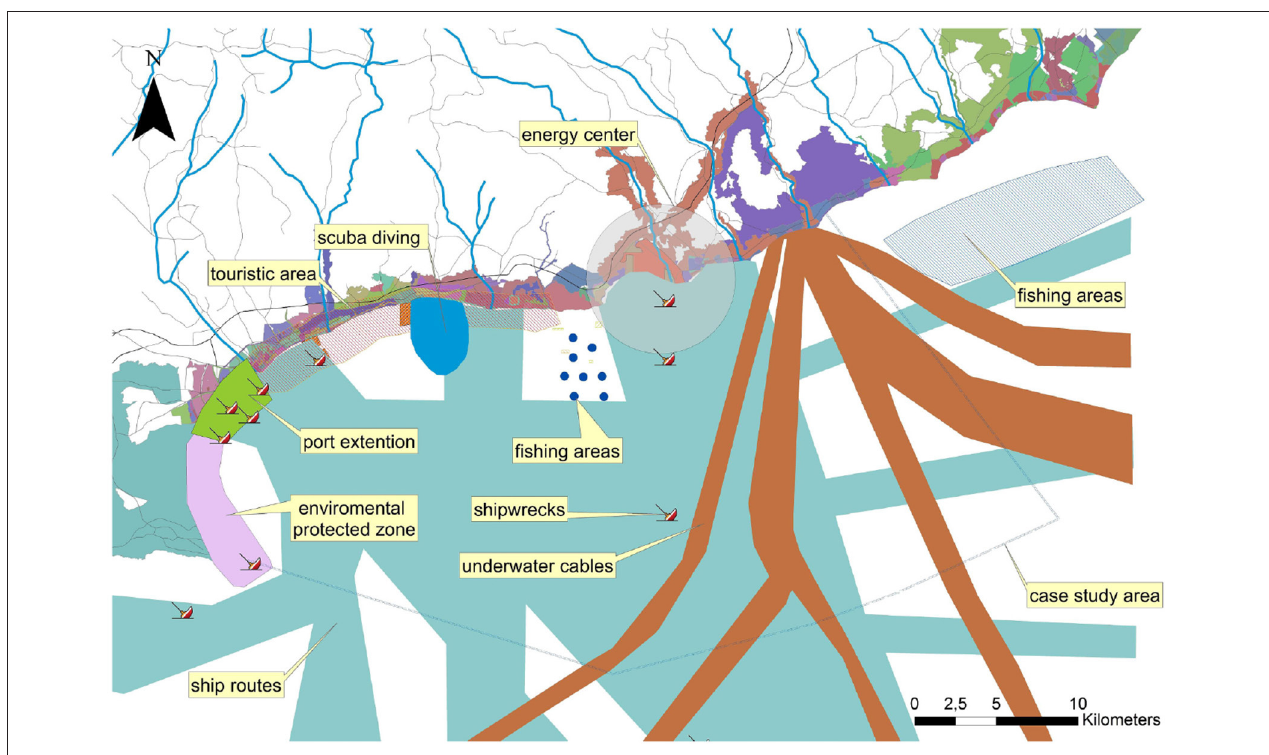
FIGURE 1 | Real MSP map (Hadjimitsis et al.,